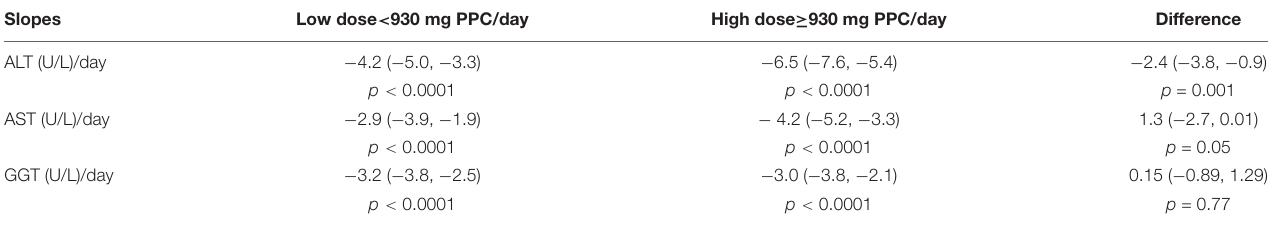
TABLE 5 | Compare effects of high vs. low dose PPC on liver function. Slopes